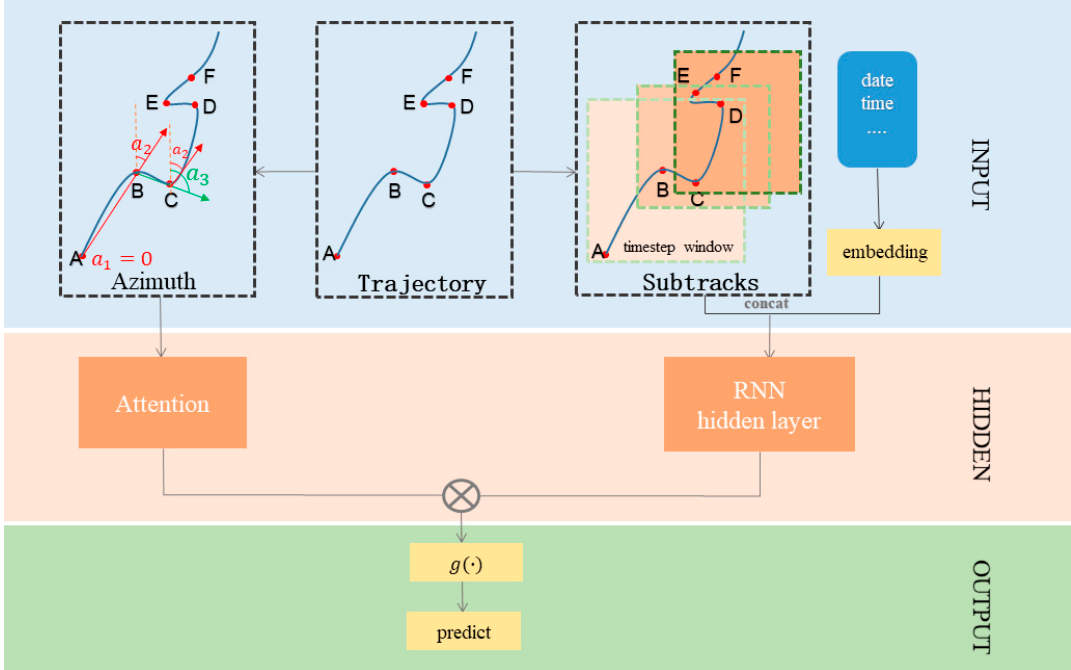
Figure 1. Attention recurrent neural network (RNN) structure.